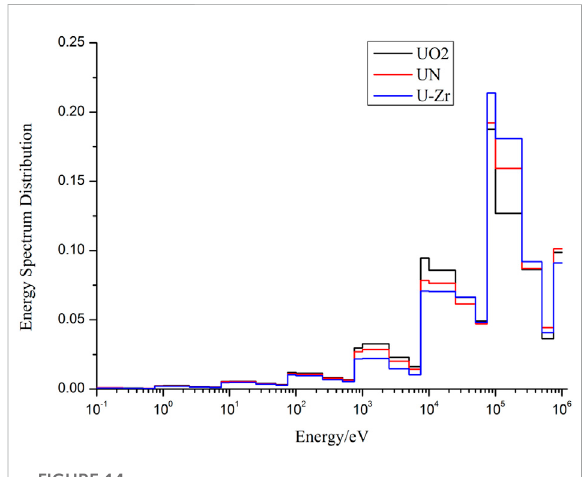
FIGURE 16 Core con fi guration of the fuel partitioning.